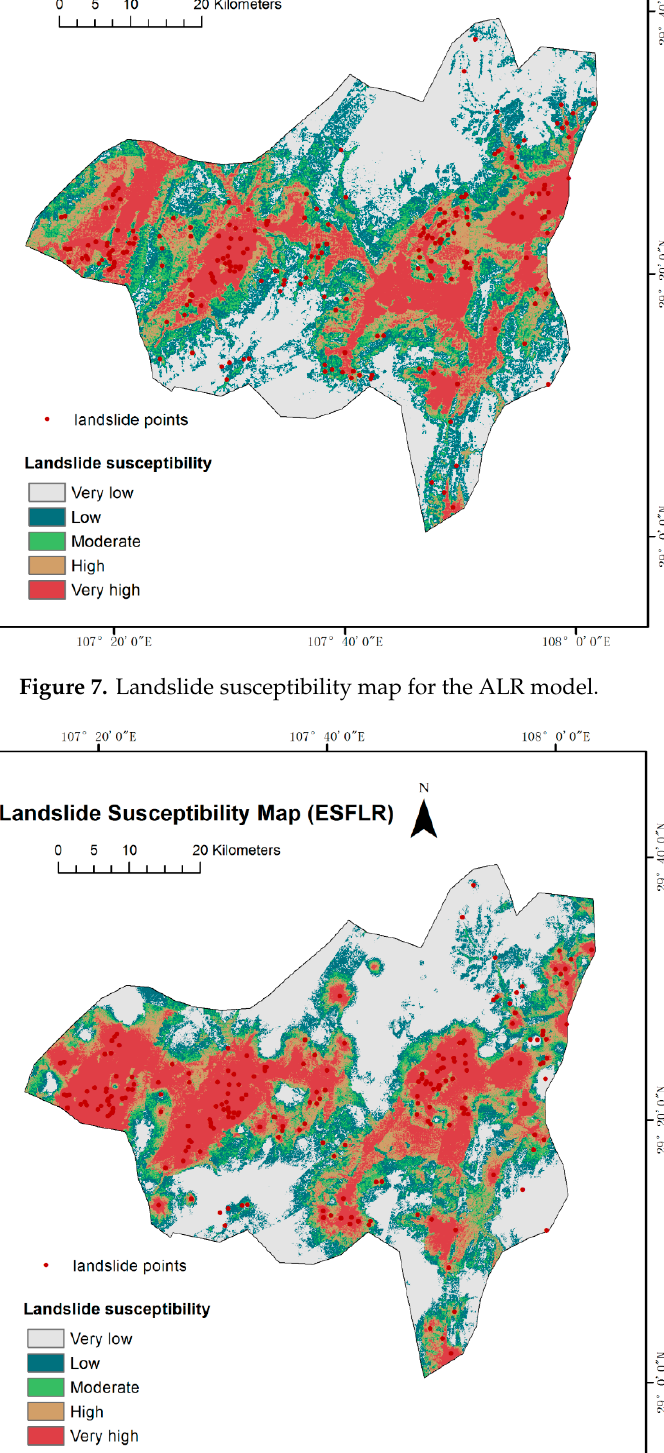
Figure 8. Landslide susceptibility map for the ESFLR model.